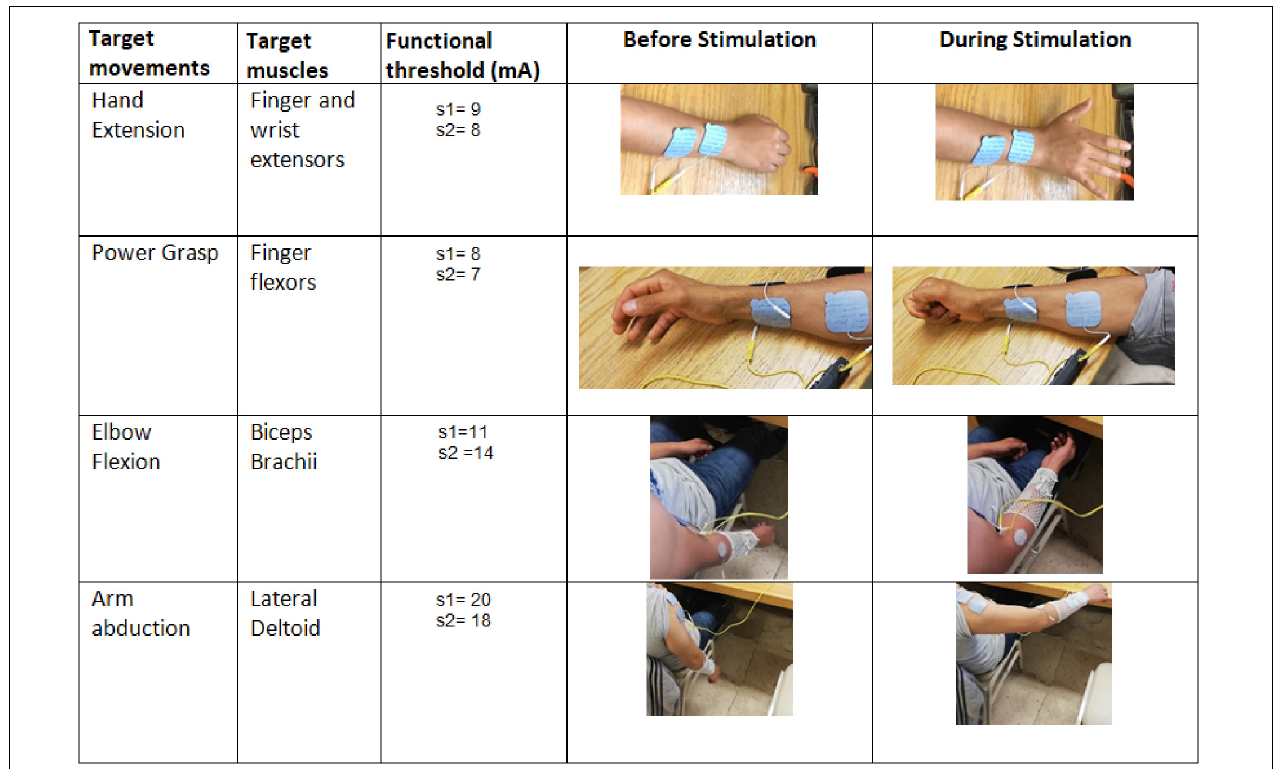
FIGURE 7 | Proof-of-concept of the PG-nFES for non-invasive transcutaneous FES applications. In the first two columns (from the left), the name of the target movements and muscles are shown. The third column shows the functional thresholds used for each subject to generate each target movement. The fourth and fifth columns contain pictures of the hand or arm before and during (respectively) the delivery of the bursts of stimulation pulses to the target muscles.